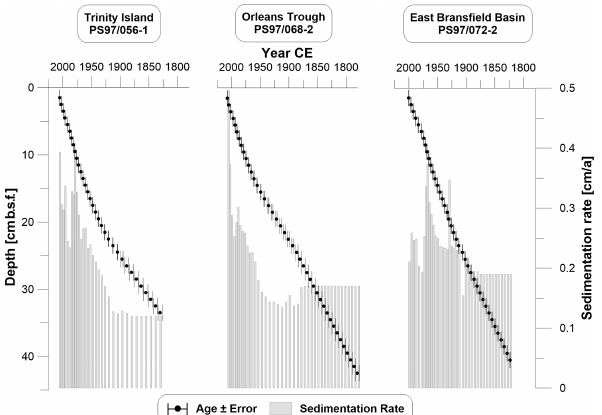
Figure 2. Age–depth models with error bars for all three cores. The sedimentation rate is displayed as grey bars. Ages are based on radiometric dating and were extrapolated prior to 1880CE for all cores based on the average respective sedimentation rate of the three lowermost reliably dated intervals. All plots were done with Grapher™